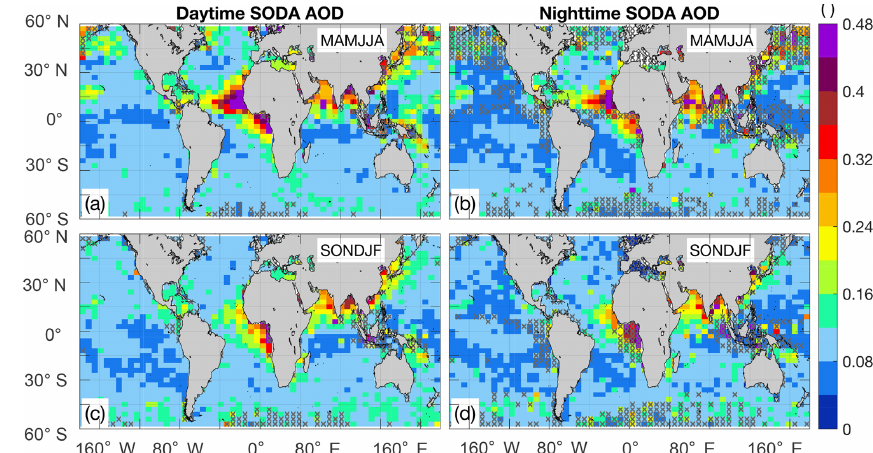
Figure 11. SODA AOD for daytime (a, c) and nighttime (b, d) spring–summer (MAMJJA) and autumn–winter (SONDJF). Gray crosses are described in Fig. 9.